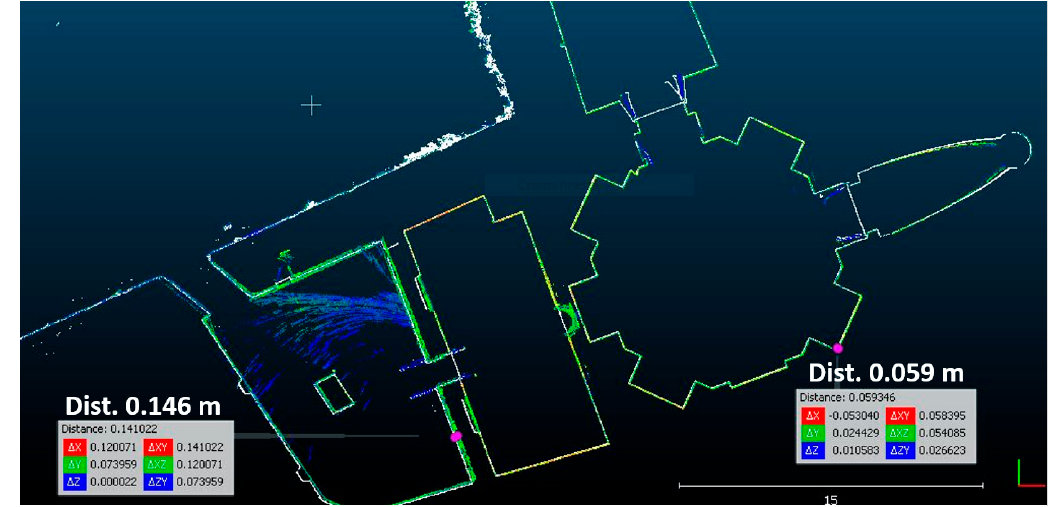
Figure 8. Kaarta Stencil, path 1. Detail of the horizontal section (reference data in white, compared dataset in colour).